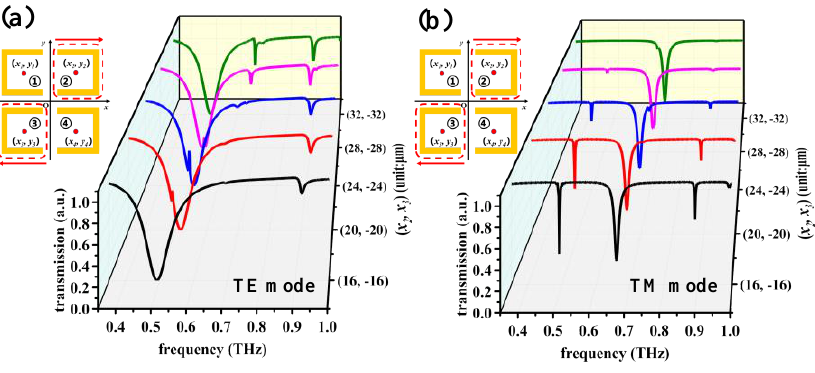
Figure 8. Simulated transmission spectra of the RTM device obtained by moving the SRR-2 and SRR-3 meta-atoms along positive and negative x -axis directions in ( a ) TE and ( b ) TM modes,